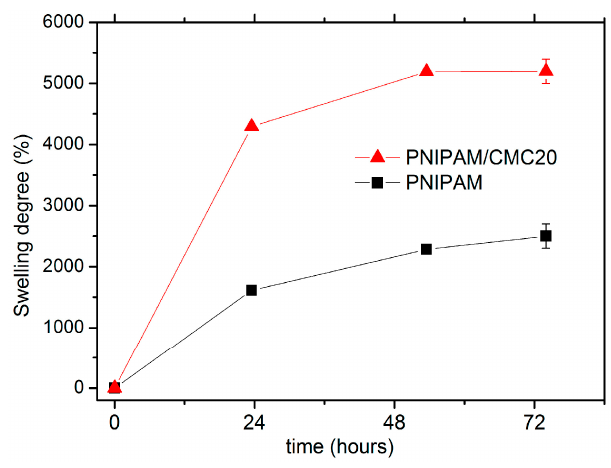
Figure 5. Swelling kinetics of PNIPAM and PNIPAM/CMC20 hydrogels in water at 295 K.